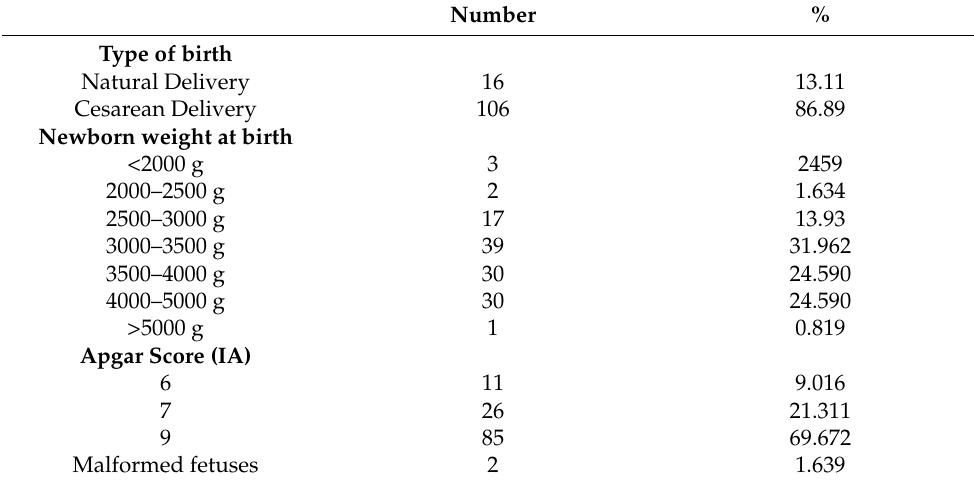
Table 3. Obstetric/neonatal outcomes of the GDM